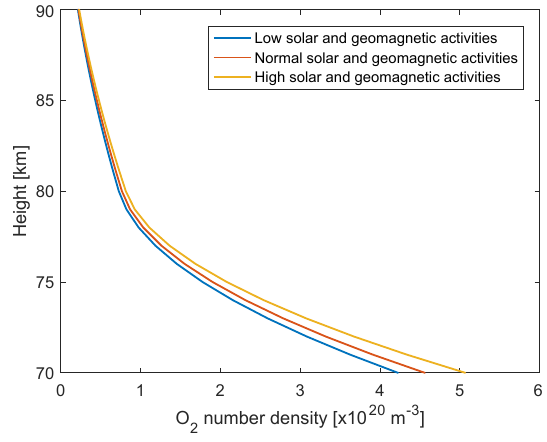
Figure 2. Comparison of O 2 number density between 70 and 90km altitude, based on the NRLMSISE-00 atmospheric model.